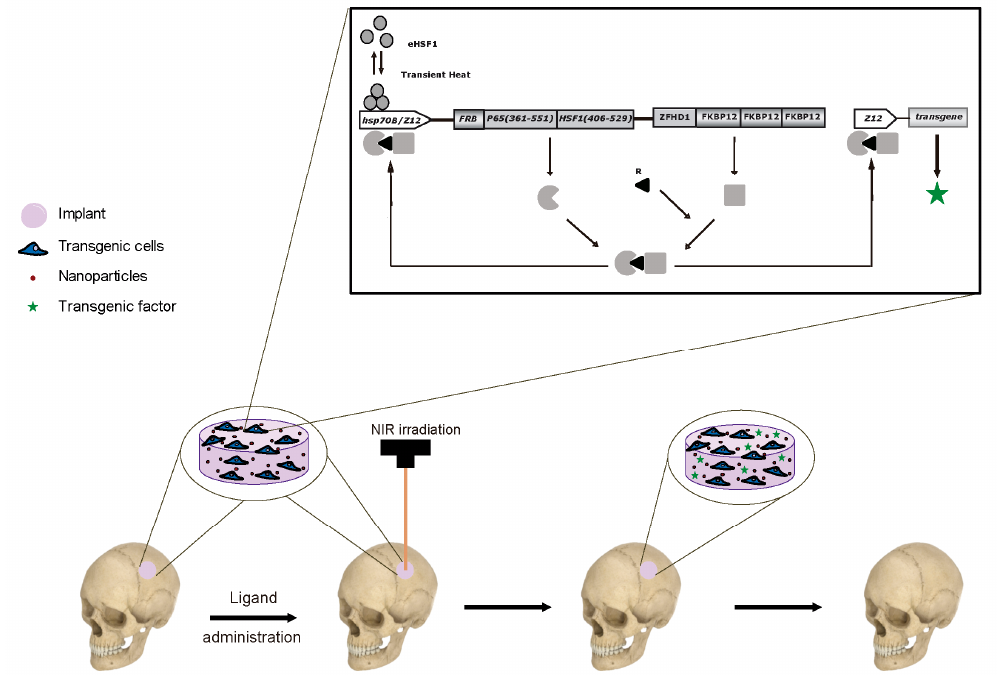
Figure 3. Cranioplasty conducted using NIR-responsive implants. A scaffold containing genetically modified cells that harbor a heat-activated and dimerizer-dependent gene expression system to control the expression of a transgene is implanted in a cranial lesion. The gene expression system is composed of a bi-cistronic gene encoding the 2 component proteins of a dimerizer-regulated transactivator and is expressed under the control of promoter cassette hsp70B/Z12, which responds to activated endogenous heat shock factor 1 (eHSF1) as well as the dimerizer-activated transactivator. Transactivator-responsive promoter Z12 controls the linked transgene. R: rapamycin. For additional details on the expression system, see [187]. After administration of a dimerizer, the implantation area is NIR-irradiated, resulting in local activation of transgene expression that stimulates bone healing. The figure includes an image retrieved from https://free3d.com/es/modelo-3d/caucasoid-male- skull-4837.html, accessed on 30 August